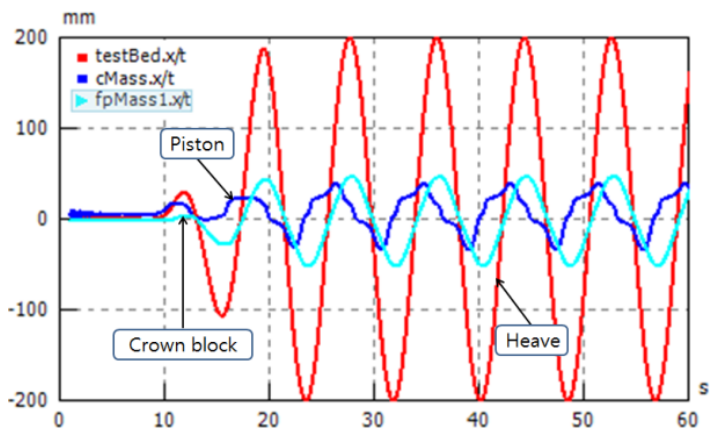
Figure 8. Basic characteristics of the analysis model.